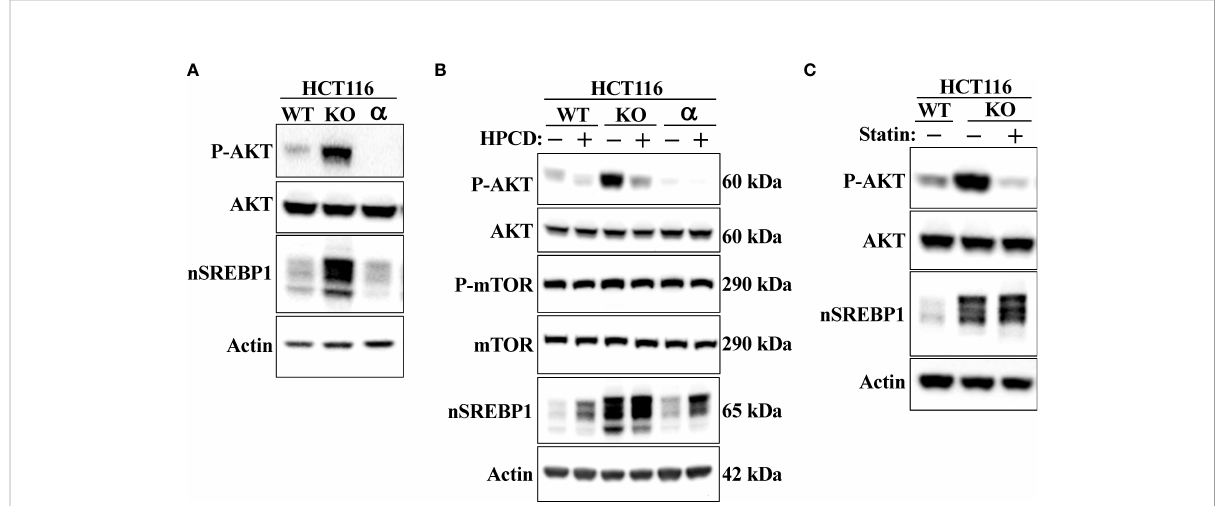
FIGURE 7 Loss of Fbw7 a activates AKT. (A) HCT116 cells, either wild-type ( WT ), Fbw7 knockout ( KO ), or the same cells reconstituted with Fbw7 a ( a ) were lysed and the levels of AKT, nuclear SREBP1 ( nSREBP1 ), b -actin, and the phosphorylation of AKT on Ser473 (P-AKT) were determined by Western blotting. (B) HCT116 cells, either wild-type ( WT ), Fbw7 knockout ( KO ), or the same cells reconstituted with Fbw7 a ( a ) were left untreated (-) or treated ( + ) with HPCD for 2 hours. The cells were lysed and the levels of AKT, mTOR, nuclear SREBP1 ( nSREBP1 ), b -actin, and the phosphorylation of AKT on Ser473 ( P-AKT ) and mTOR on Ser2448 ( P-mTOR ) were determined by Western blotting. (C) Wild-type (WT) or Fbw7 knockout ( KO ) HCT116 cells were either left untreated (-) or treated ( + ) with fl uvastatin ( Statin ) for 12 hours (2 m M), lysed and the levels of AKT, nuclear SREBP1 ( nSREBP1 ), b -actin, and the phosphorylation of AKT on Ser473 ( P-AKT ) were determined by Western